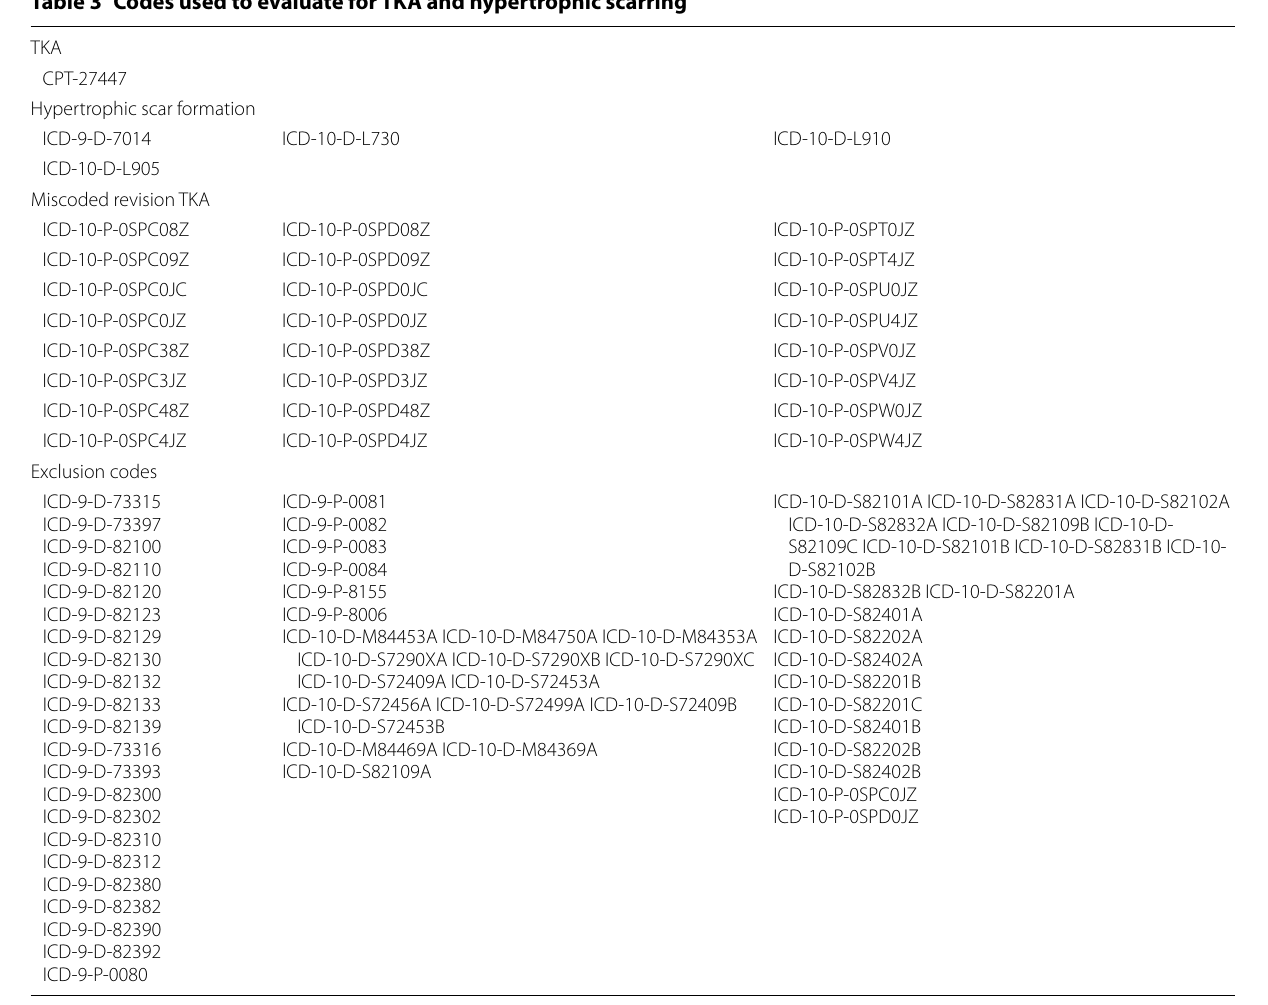
Table 3 Codes used to evaluate for TKA and hypertrophic